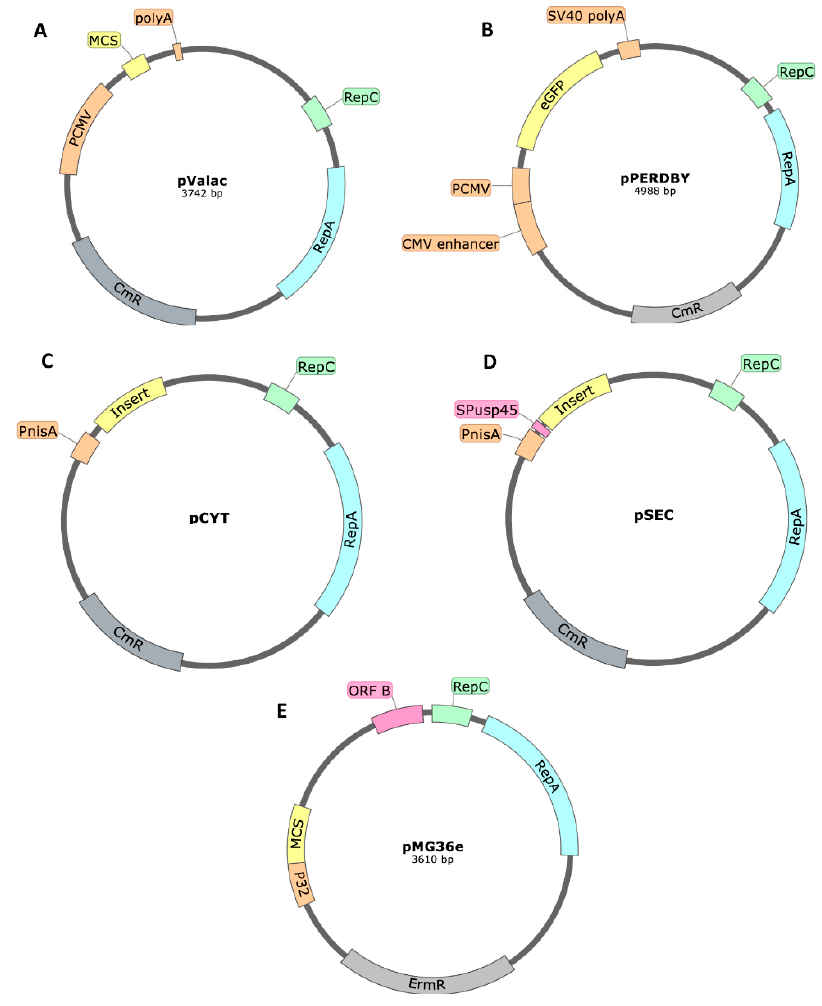
Figure 4. Structure of the pWV01-based plasmids ( A ) pValac [51], ( B ) pPERDBY [54], ( C ) pCYT [94], ( D ) pSEC [94] and ( E ) pMG36e [90]. The plasmids generally contain the replication origin genes ( repC and repA ), the antibiotic resistance gene (chloramphenicol, cm R , or erythromycin, erm R ) and the gene of interest under the control of a eukaryotic (the cytomegalo- virus promoter, P CMV ) or prokaryotic promoter (inducible, such as P nisA or constitutive, such as P 32 ). The eukaryotic expres- sion plasmids also have a polyadenylation region